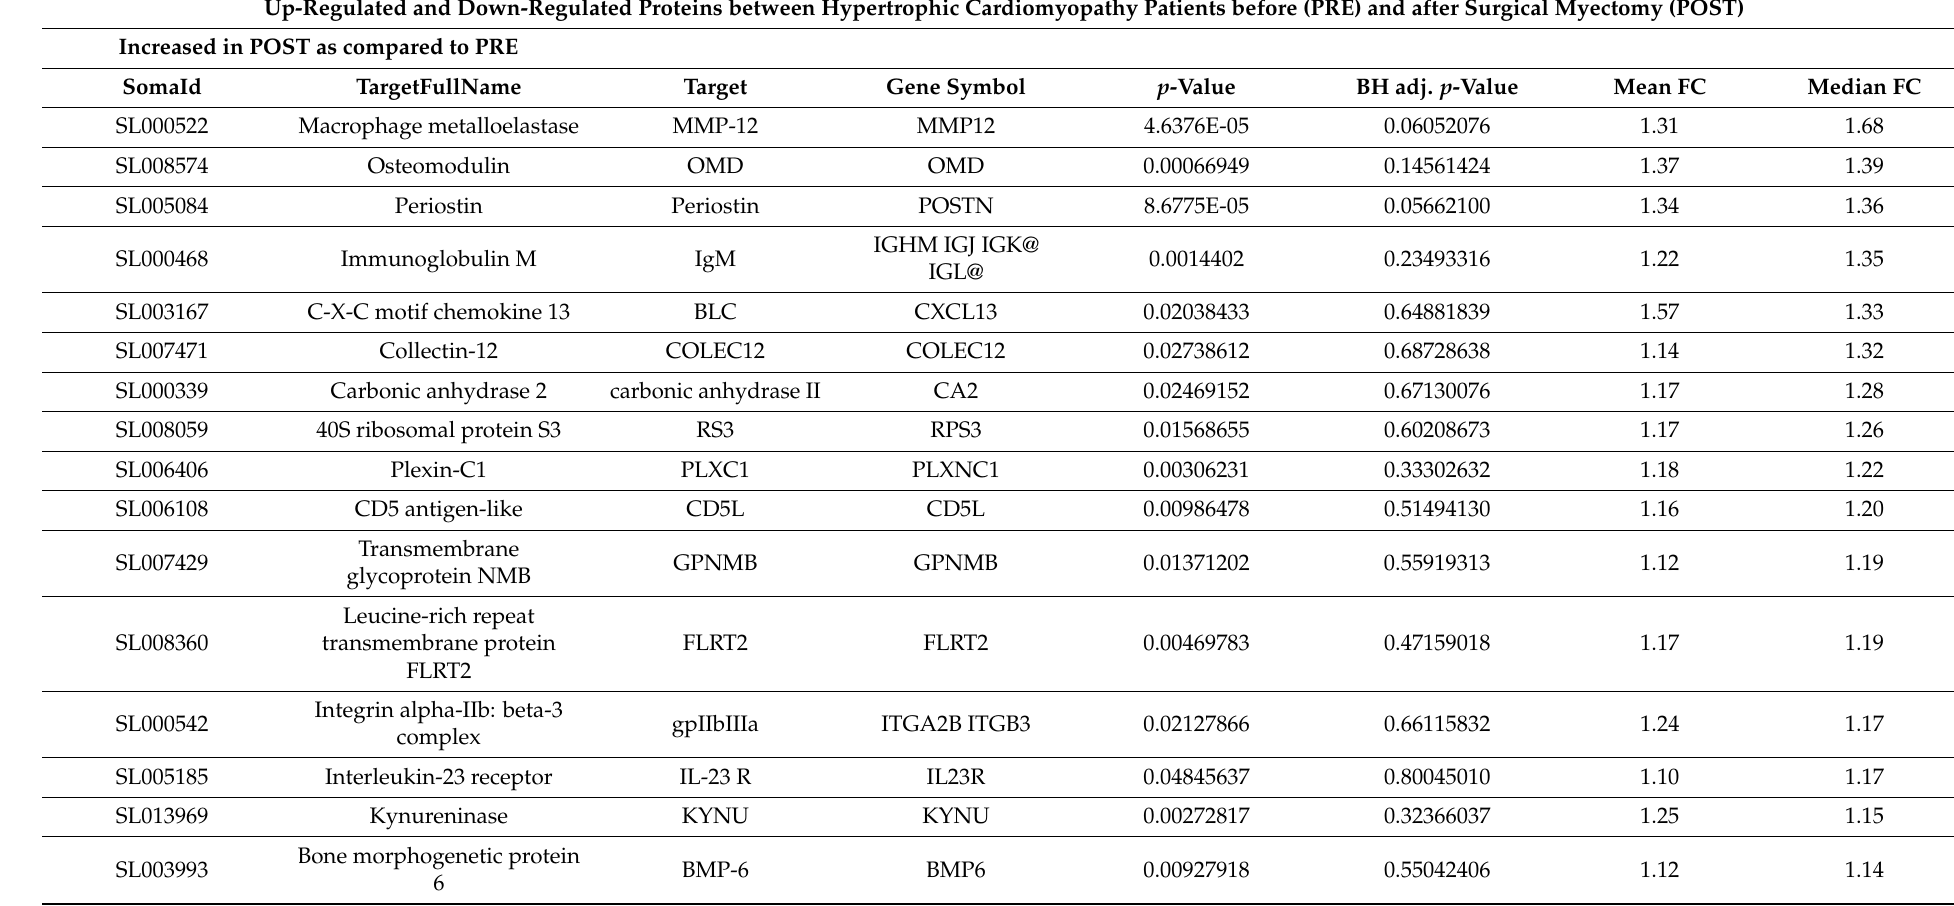
Table 2. Upregulated and Downregulated proteins between Hypertrophic Cardiomyopathy Patients before (PRE) and after Surgical Myectomy (POST).